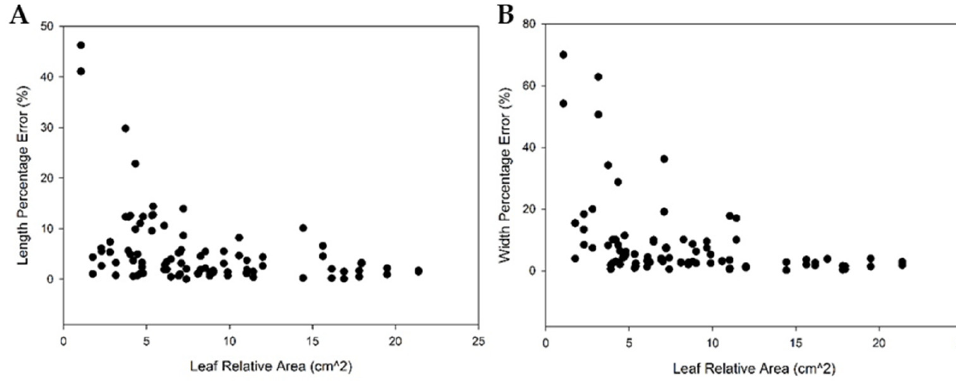
Figure 7. Percentage error by leaf relative area; ( A ) leaf length and ( B ) leaf width.